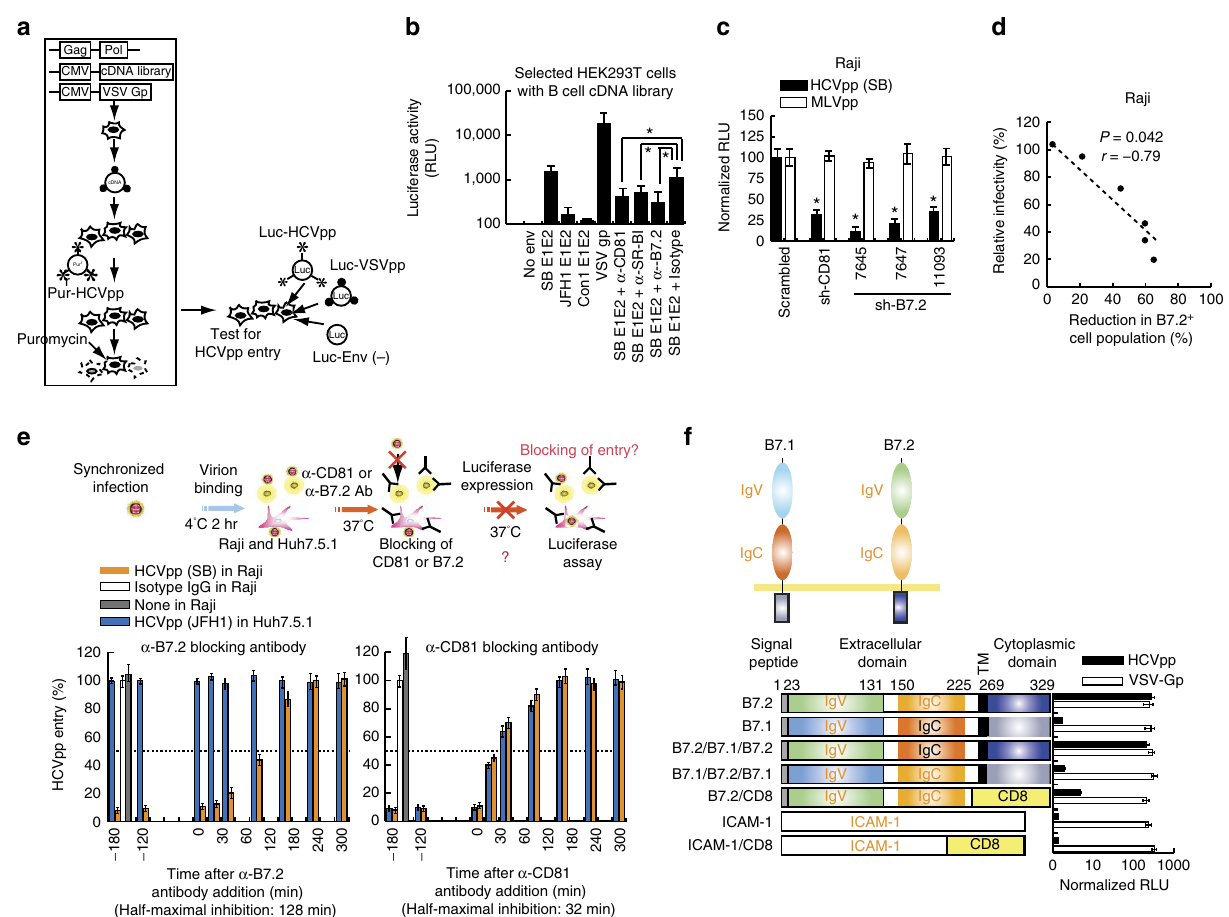
Figure 5 | Co-stimulatory molecule B7.2/CD86 is identified as a co-receptor for lymphotropic HCV infection in B lymphocytes. ( a ) Expression cloning of lymphotropic HCV receptor. HEK293Tcells were transfected with B-cell cDNA library and selected with functional screening using HCVpp(SB) as the ligand and puromycin or other selection antibiotic. To recover B-cell cDNAs in selected (surviving) colonies, DNA was isolated from these selected HEK293T cells and amplified by PCR with specific primers to identify the inserted cDNA library sequence. ( b ) The blocking effects of anti-B7.2 and anti-CD81 on HCVpp(SB) infection (* P o 0.05, t -test, n ¼ 3). Error bars represent s.d. ( c ) B7.2 silencing inhibited HCVpp-SB entry into Raji cells. The HCVpp entry experiment was performed in triplicate ( n ¼ 3). Error bars represent s.d. ( d ) Correlation plot between B7.2 levels and relative infectivity. ( e ) Time course of the blocking effects of anti-B7.2 and anti-CD81 on HCVpp(SB) infection. Synchronized infections were performed on Raji or Huh7.5.1 cells. Values (percent entry) are relative to the signal seen when the antibody was added at 4h post temperature shift. Cellular HCV RNA levels were detected in Raji cell cultures treated with isotype-matched or anti-B7.2 or anti-CD81 antibody. Fits of t ¼ 0 and later data points represent a one-phase exponential association and sigmoidal dose-response (variable slope) for anti-B7.2 (50 m gml (cid:2) 1 ) or anti-CD81 (50 m gml (cid:2) 1 ) antibody (mean of n ¼ 3; error bars, s.d.). ( f ) Both B7.2 IgV and cytoplasmic regions are required for efficient HCV entry. The Raji cells (B7.2 low ) transduced with lentivirus expressing sh-B7.2 were electroporated with GFP-B7.2 (B7.2), GFP-B7.2/CD8 (B7.2/CD8), GFP-ICAM-1 (ICAM-1) or GFP-ICAM-1/CD8 (ICAM-1/CD8) vectors. HCV entry levels were assessed for luciferase activities at 72h after HCVpp challenge of transfected cells ( n ¼ 3). Error bars represent s.d. coimmunoprecipitation with anti-B7.2, followed by immunoblot B cells than in naı¨ve B cells isolated from HCV patients, which is correlated with increased protein levels of B7.2 (Fig. 6d). These findings were confirmed by examination of 18 different hepatitis C patients (Fig. 6e). Lower surface B7.2 levels were correlated with lower cellular HCV RNA levels (Supplementary Fig. 5D). Activation of B cells (CD40L þ IL-4 treatment) is known to promote surface B7.2 expression in naı¨ve B cells 59 . Interestingly, activation of B cells resulted in higher levels of cellular HCV RNA 8 days post-HCV (SB/JFH1) infection (Supplementary Fig. 5E). Anti-CD81, anti-SR-BI or anti-E2 neutralizing antibody treatment blocked HCV infection in sh- RIGI -Raji cells (Supplementary Fig. 5F). B7.2 expression in B and T cells and dendritic cells was confirmed by immunoblot (Supplementary Fig. 5G). These results indicated that CD81, SR-BI and E2 are involved in critical steps for lymphotropic HCV entry process into B cells. This conclusion is limited to B cells, but not in T-cell NATURE COMMUNICATIONS|8:13882|DOI: